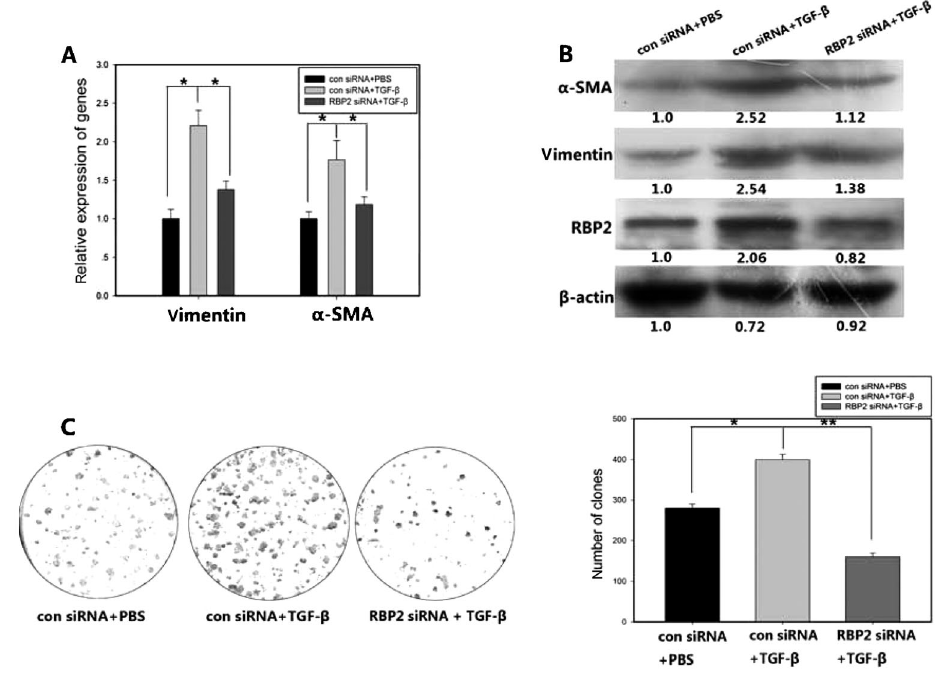
Figure 3. The activation of LX-2 cells by TGF- b was attenuated by RBP2 suppression. Quantification ( A ) and Western blot analysis ( B ) of a -SMA and vimentin after treatment with RBP2 siRNA and TGF- b (5 ng/mL). Data are reported as means±SD from 3 experiments (Student t -test; *P , 0.05). C , Proliferation of LX-2 cells treated with RBP2 siRNA and TGF- b . The Student t -test was used for analysis (*P , 0.05, **P ,